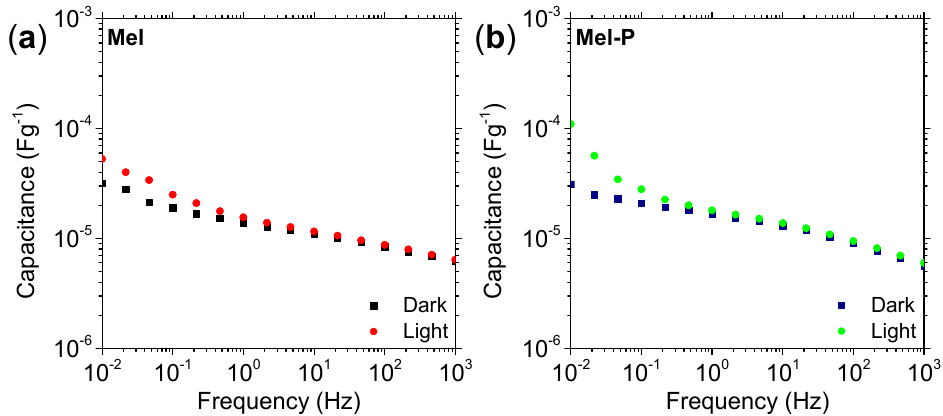
Figure 6. The frequency-dependence capacitance of ( a ) Mel and ( b ) Mel-P under dark and light conditions.